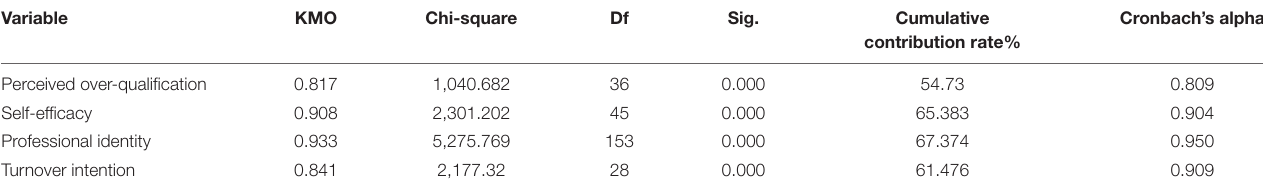
TABLE 2 | Reliability and validity test results. Variable KMO Df